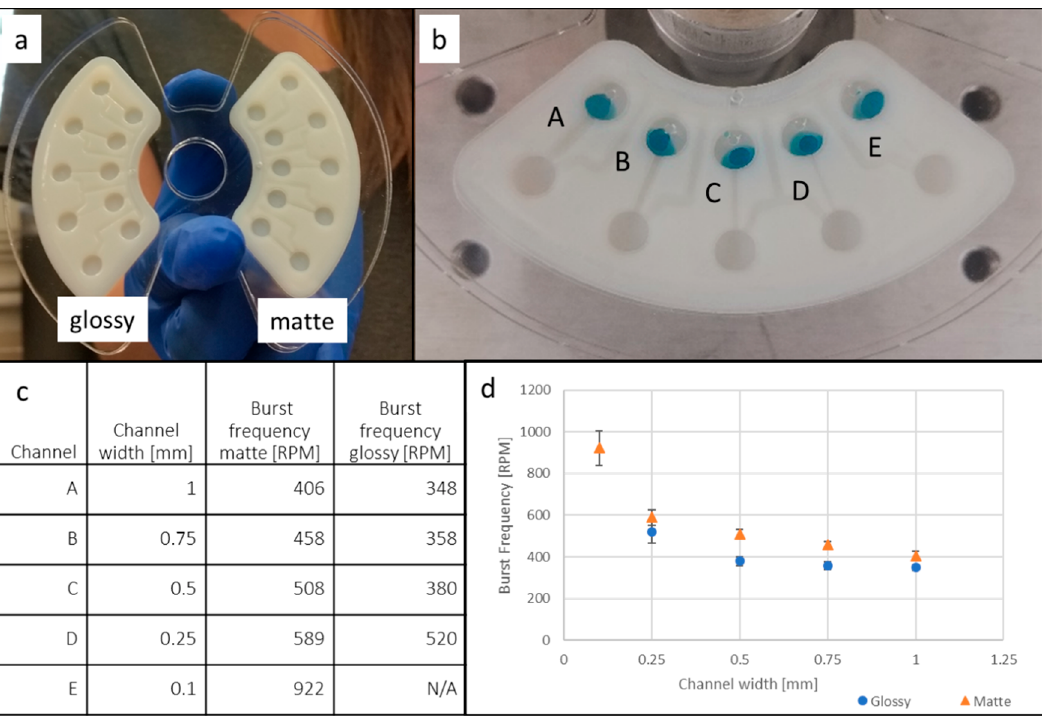
Figure 6. Burst frequency testing of 3D printed inserts with glossy and matte surface finish. ( a ) Inserts with different surface finish in a laser-cut acrylic holder. ( b ) Naming convention of channels, with decreasing channel widths left to right. ( c ) Average burst frequencies for channels A through E. Channel E did not resolve in the glossy surface finish part due to limited resolution. ( d ) Graph of burst frequency as a function of channel width. Blue/round symbols are burst frequencies of glossy and orange/triangular are burst frequencies for the matte part. Error bars represent the standard deviation. The number of tests for each channel was 10 and the volume of deionized dyed water per channel was 20 μ L.